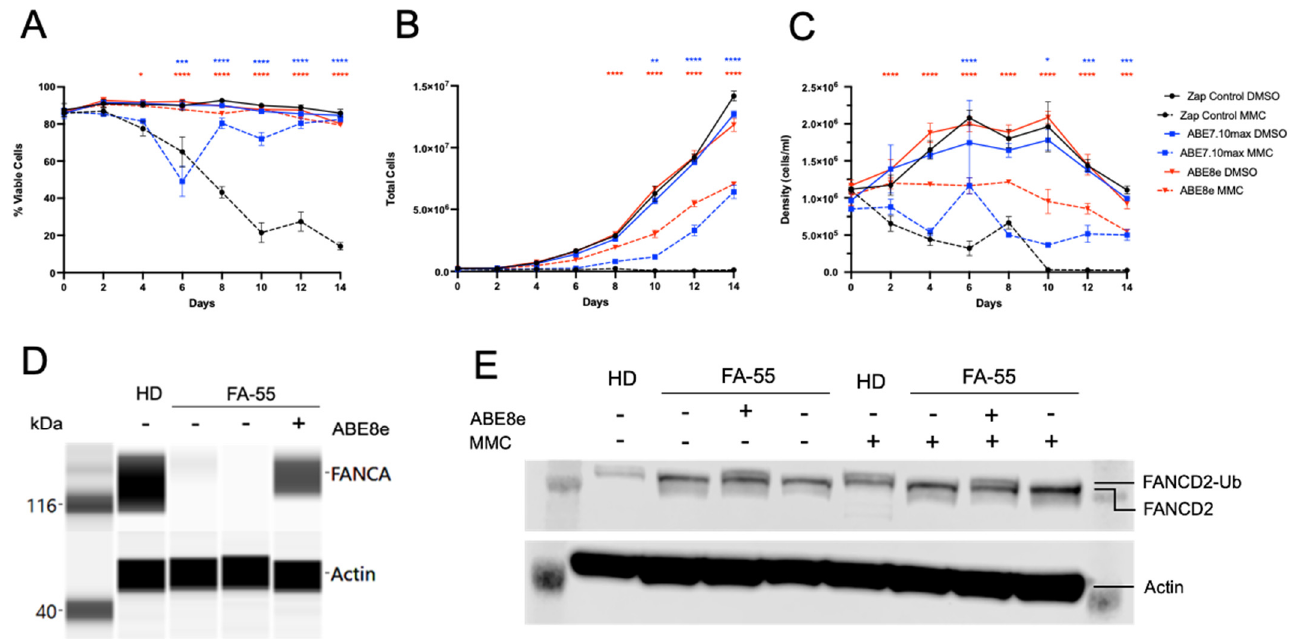
Figure 5. Phenotypic restoration of the FA pathway after base editing the Spanish founder mutation. MMC hypersensitivity in edited and unedited FA LCL with courts taken every other day showing cell viability ( A ), cell expansion ( B ), and cell density ( C ). All data are represented as mean ± SD with n = 3 replicates. (* p < 0.05, ** p < 0.001, *** p < 0.0005, **** p < 0.0001). ( D ) FANCA Western blot before and after editing showing protein product restoration using the Anti-Rabbit Detection Module for Jess/Wes. ( E ) Traditional FANCD2 Western blot run on 4–12% Bis-Tris gels and PVDF membranes. The presence of a second higher molecular weight band after base editing indicates FANCD2 monoubiquitination and thus an intact FA pathway.